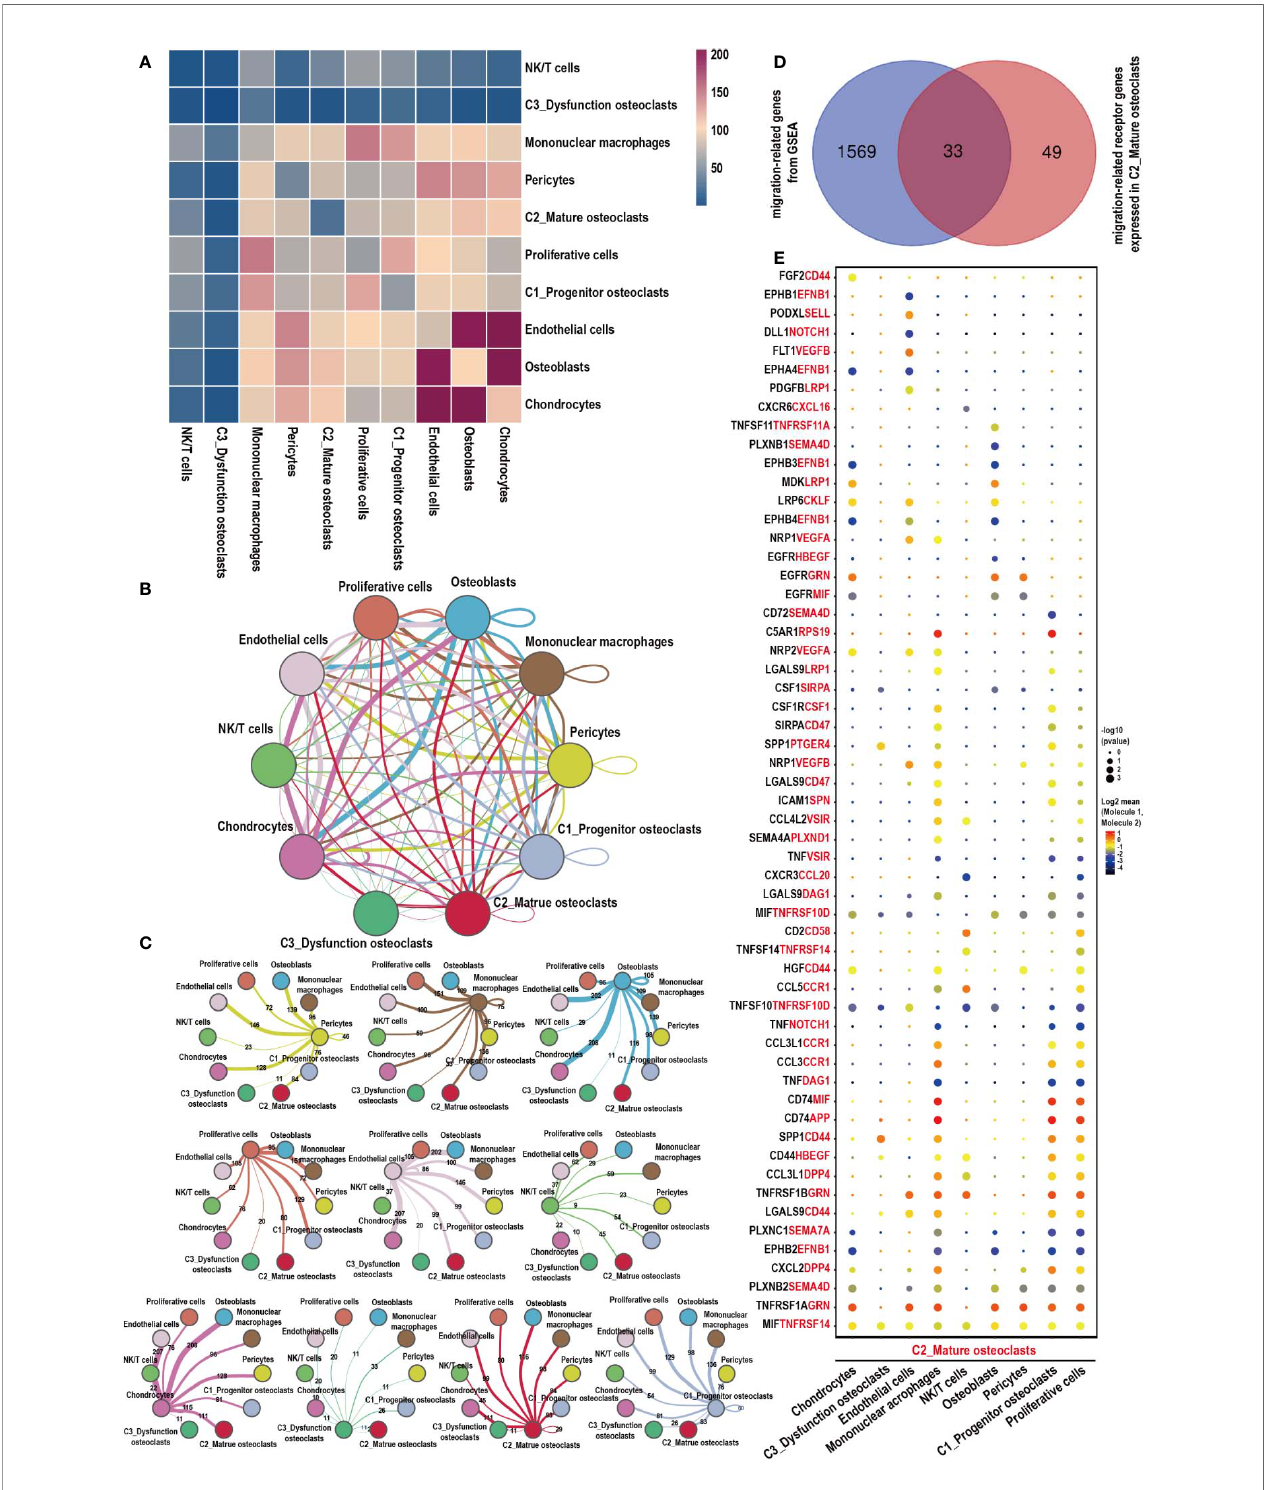
FIGURE 6 | Cell – cell communication network of CellPhoneDB in the GCTB. (A) Heatmap showing the number of potential ligand – receptor pairs among the predicted cell types. (B, C) Interaction network constructed by CellPhoneDB. Thicker lines indicate more interaction with other types of cells. (D) Venn diagram of genes related to cells migration obtained from GSEA, and those that acted as receptors expressed in C2_Mature osteoclasts in our data. (E) Ligand – receptor pairs detected with CellPhoneDB are shown in a bubble plot. GCTB, giant cell tumor of bone; UMAP, uniform manifold approximation and projection for dimension reduction; GSEA, gene set enrichment